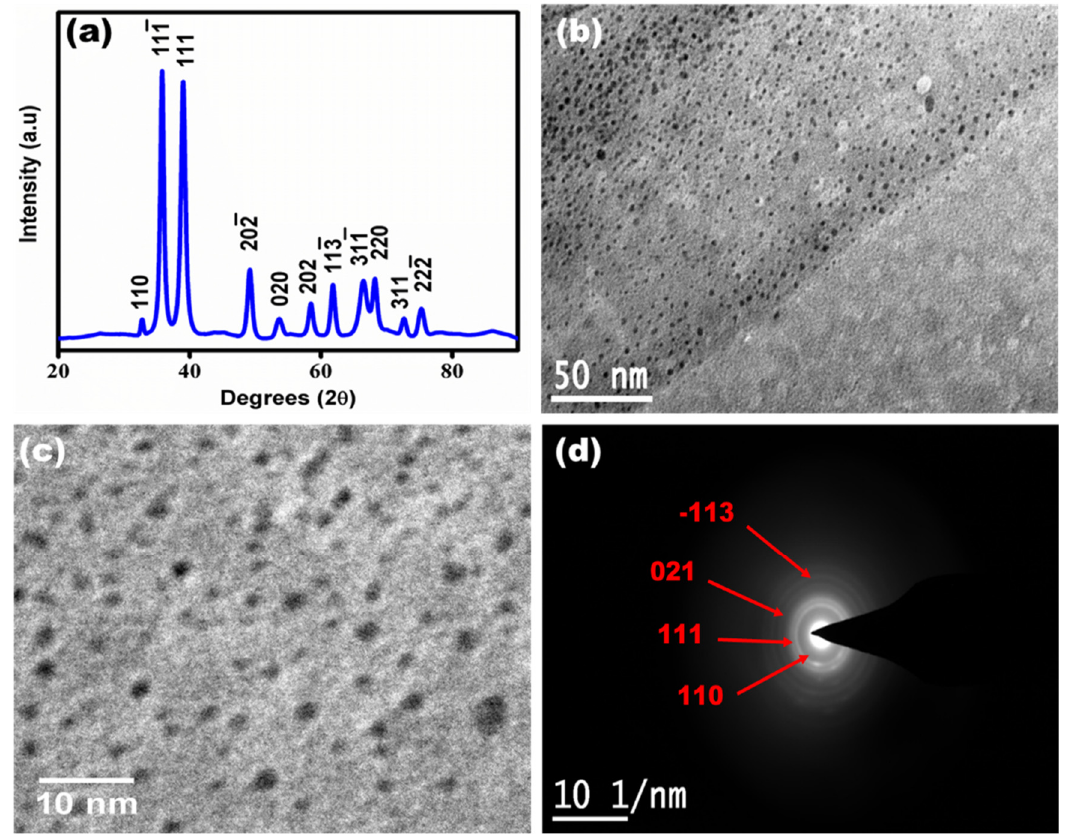
Figure 2. ( a ) XRD analysis for the synthesized copper oxide quantum dots, ( b ) HR-TEM micrograph of CuO QDs at 50 nm scale bar, ( c ) HR-TEM micrograph of CuO QDs at 10 nm scale bar and ( d ) electron diffraction pattern of CuO QDs showing the cupric oxide phase formation at 1/10 nm scale.